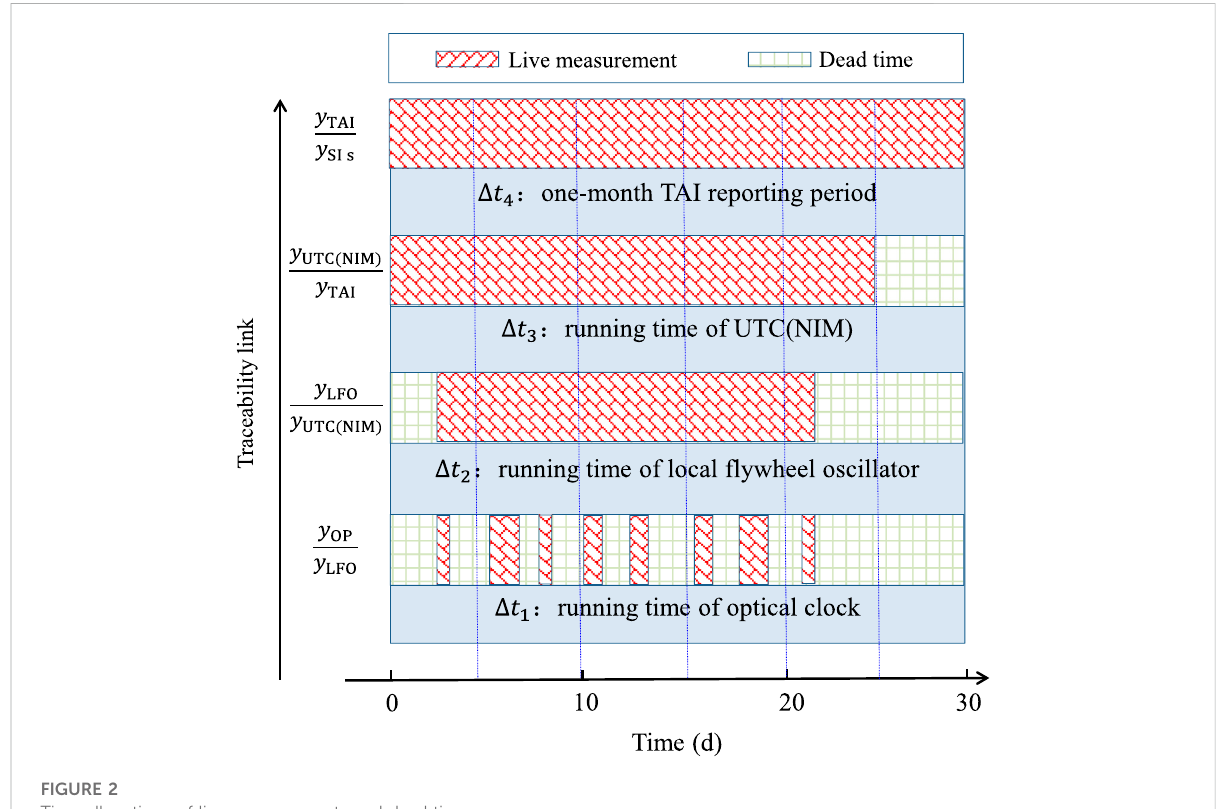
FIGURE 2 Time allocations of live measurements and dead